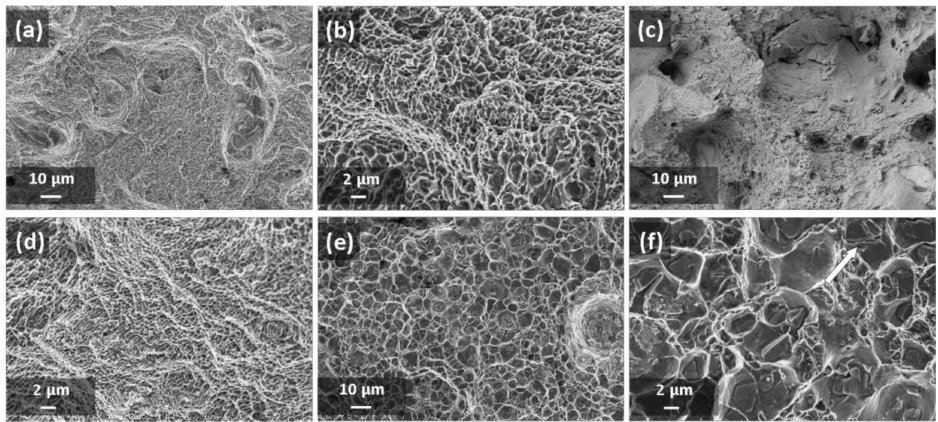
Figure 9. Fracture surfaces analysis through FESEM of A357 LPBF tensile samples: ( a , b ) as-built condition, ( c , d ) after stress-relieving, ( e , f ) after T6 B,170,3